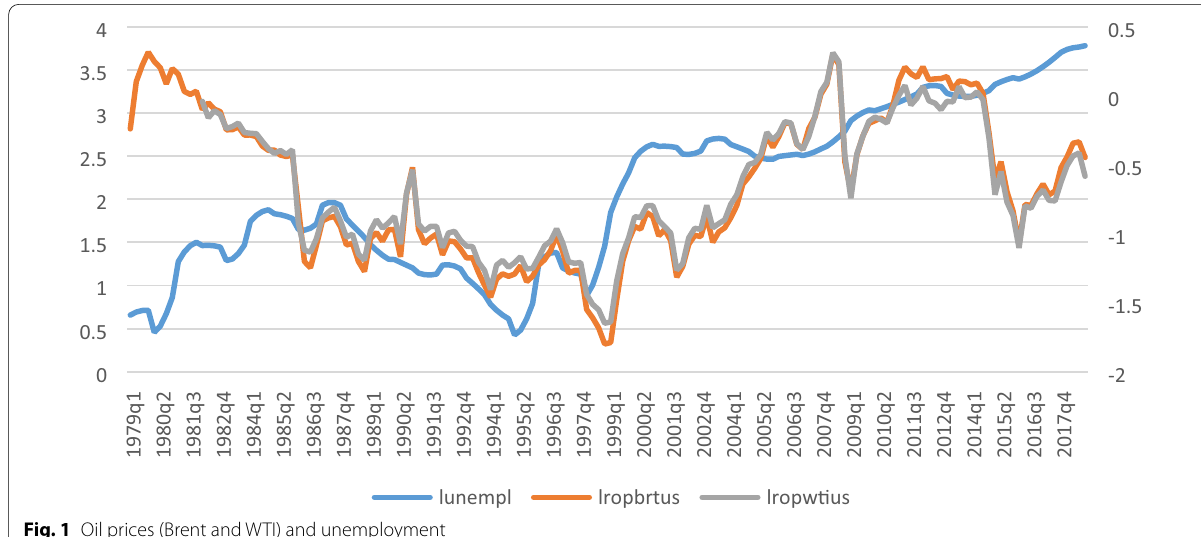
Fig. 1 Oil prices (Brent and WTI) and